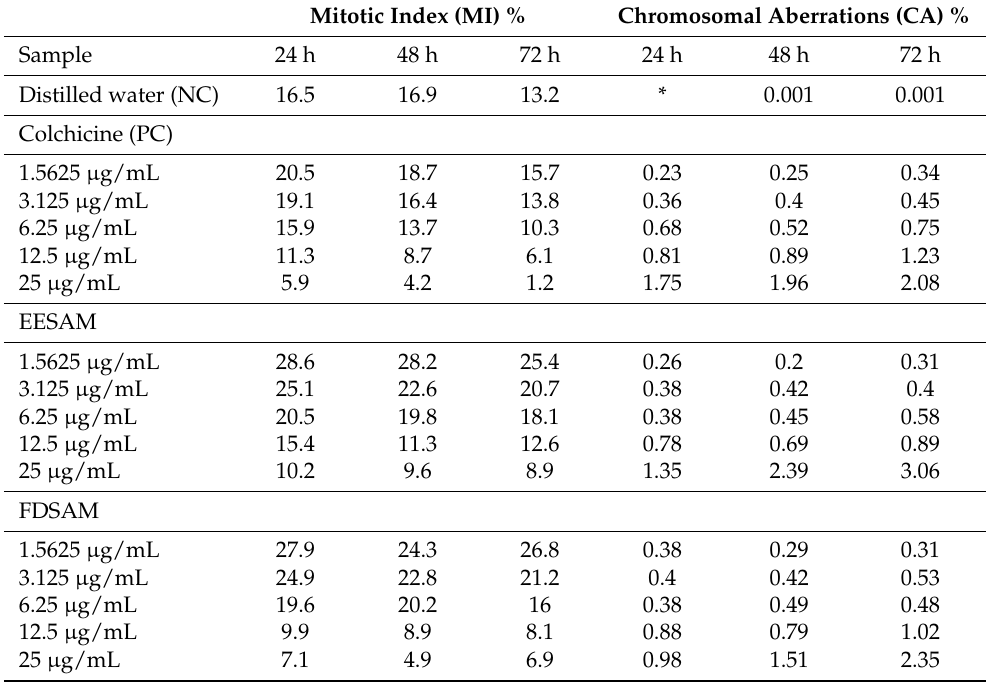
Table 2. Mitotic index and cellular aberrations in Allium cepa induced by the extract and fraction of Annona muricata . Mitotic Index (MI) % Chromosomal Aberrations (CA) % Sample 24 h 48 h Distilled water